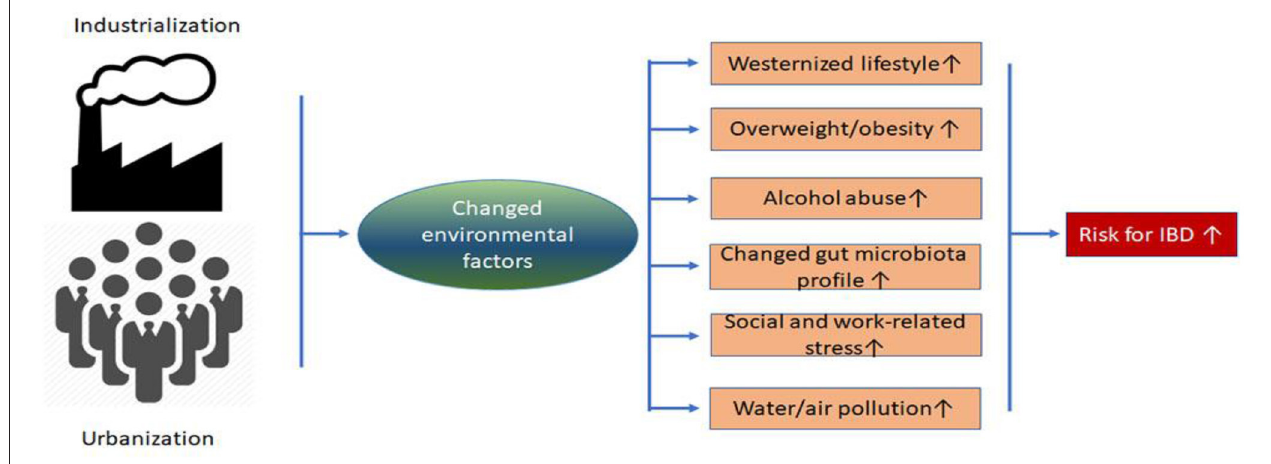
FIGURE 3 | Schematic summarized environmental risk factors induced by industrialization and urbanization for IBD. Emerging evidence suggested that accelerated industrialization and urbanization in China increase the risk for IBD through relevant environmental